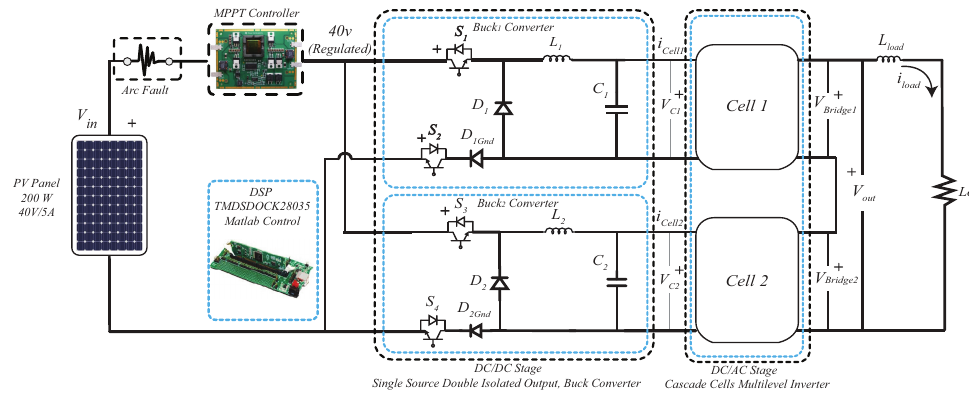
Figure 6. Overall converter diagram for arc fault